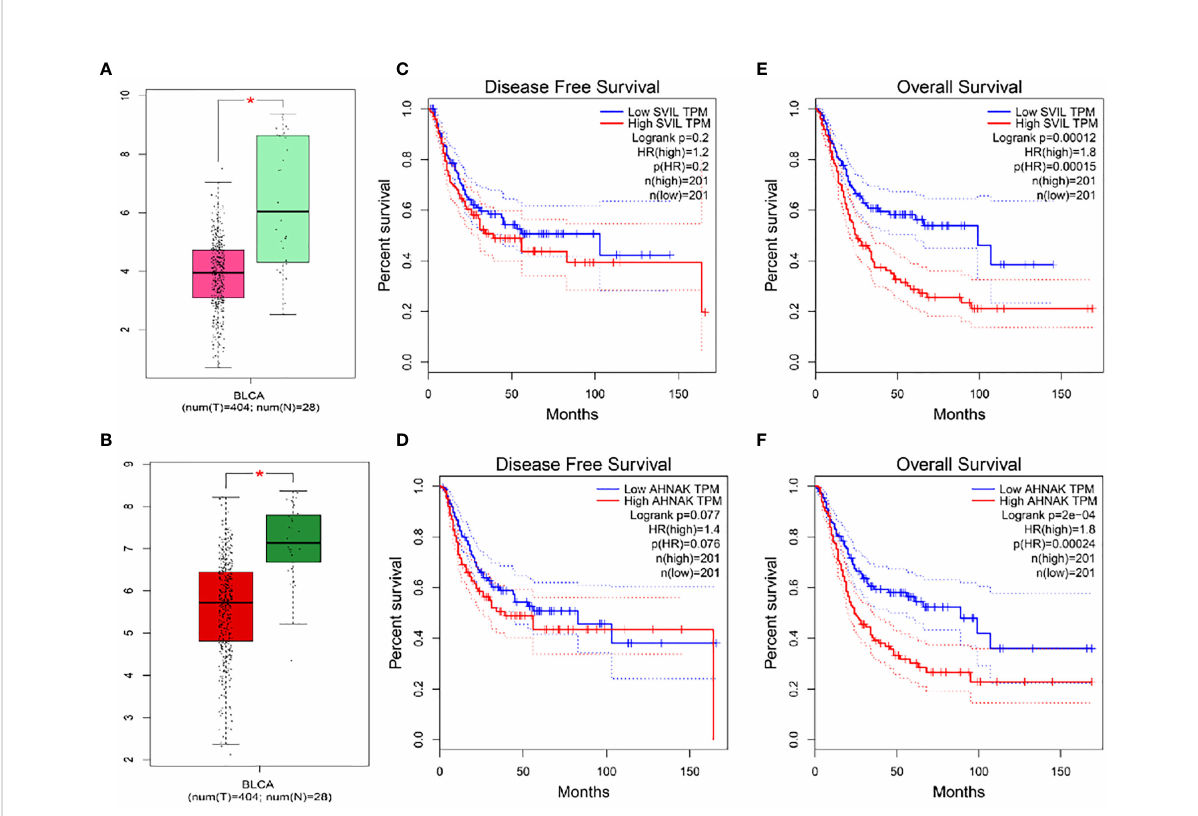
FIGURE 3 Differential expression analysis and overall survival and disease-free survival of SVIL and AHNAK were validated in the GEPIA database in combination with normal samples in the GETx database. (A) SVIL difference expression box visualization diagram; (B) AHNAK difference expression box visualization diagram; (C) Disease Free Survival for SVIL; (D) Disease Free Survival for AHNAK; (E) Overall Survival analysis for SVIL; (F) Overall Survival analysis for AHNAK. * indicates P <